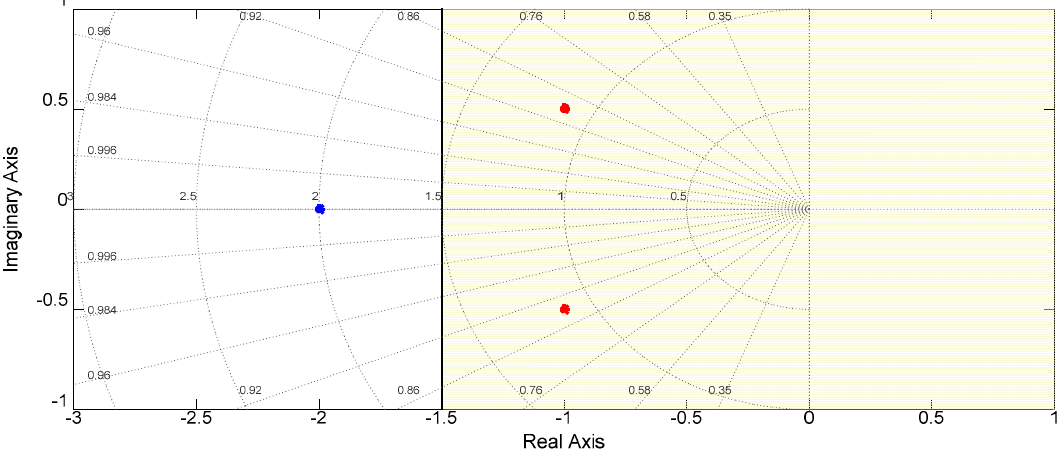
Figure 5. Displacement of the imaginary axis for relative stability analysis.